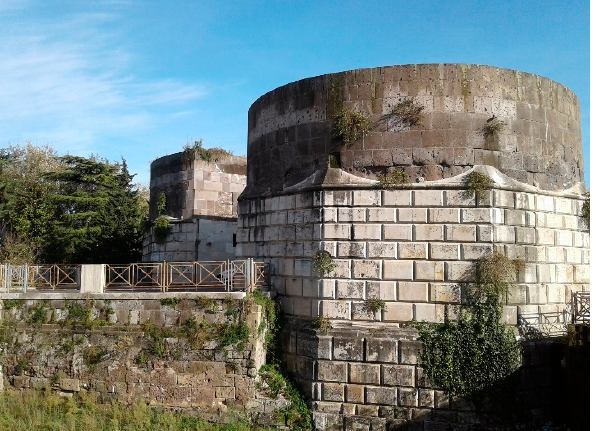
Figure 4. Capua, bridge of the Volturno River, Capua Gate, current state. Photo taken by the au- thor.